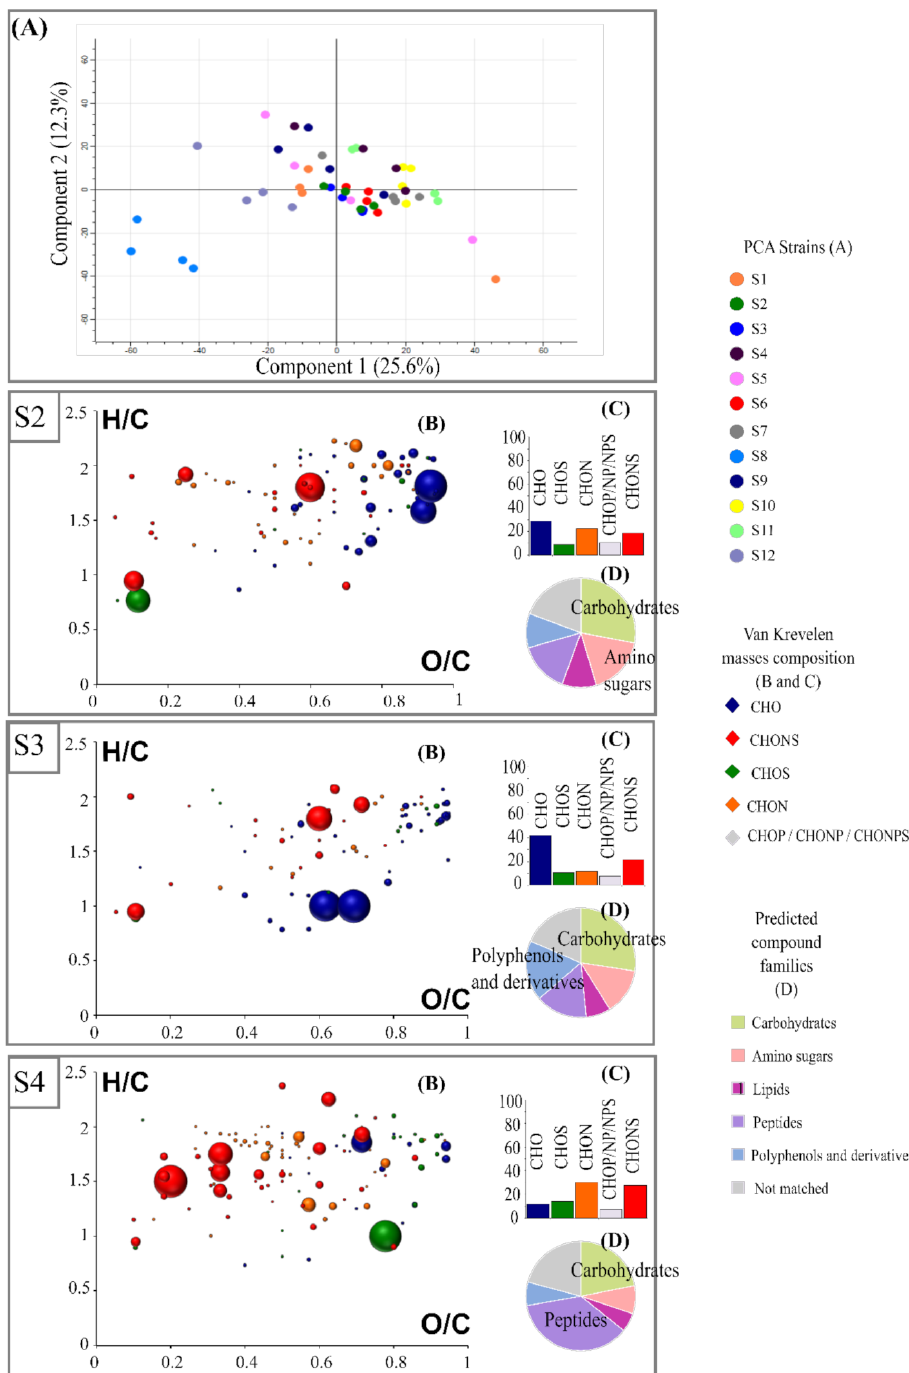
Figure 1. ( A ) Principal-component analysis of twelve Saccharomyces cerevisiae strains based on FT- ICR-MS data using direct methanol dilution. ANOVA ( p < 0.05) was used to extract specific markers for each of the twelve strains: S2, S3 and S4 are represented as examples. For each strain, H/C vs. O/C van Krevelen diagrams ( B ), histogram proportions that show their elemental compositions ( C ), and a pie chart ( D ) representing the distribution of these markers by hypothetical families of common wine compounds are presented. Bubble sizes indicate relative intensities of corresponding masses. Color code: CHO, blue; CHON, orange; CHONS, red; CHOS,